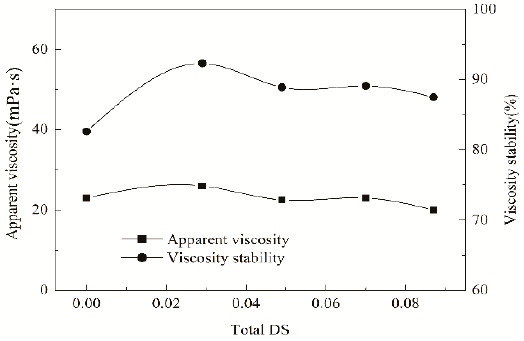
Figure 3. Apparent viscosity and its stability of gelatinized starch paste.